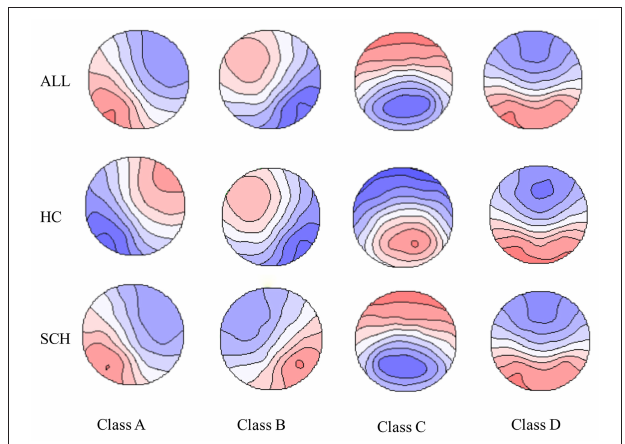
FIGURE 1 | The spatial configuration of the four microstate claasses for the two groups and all the participants. Polarity was ignored. SCH, individuals with schizophrenia; HC, healthy controls; ALL, all the participants in this